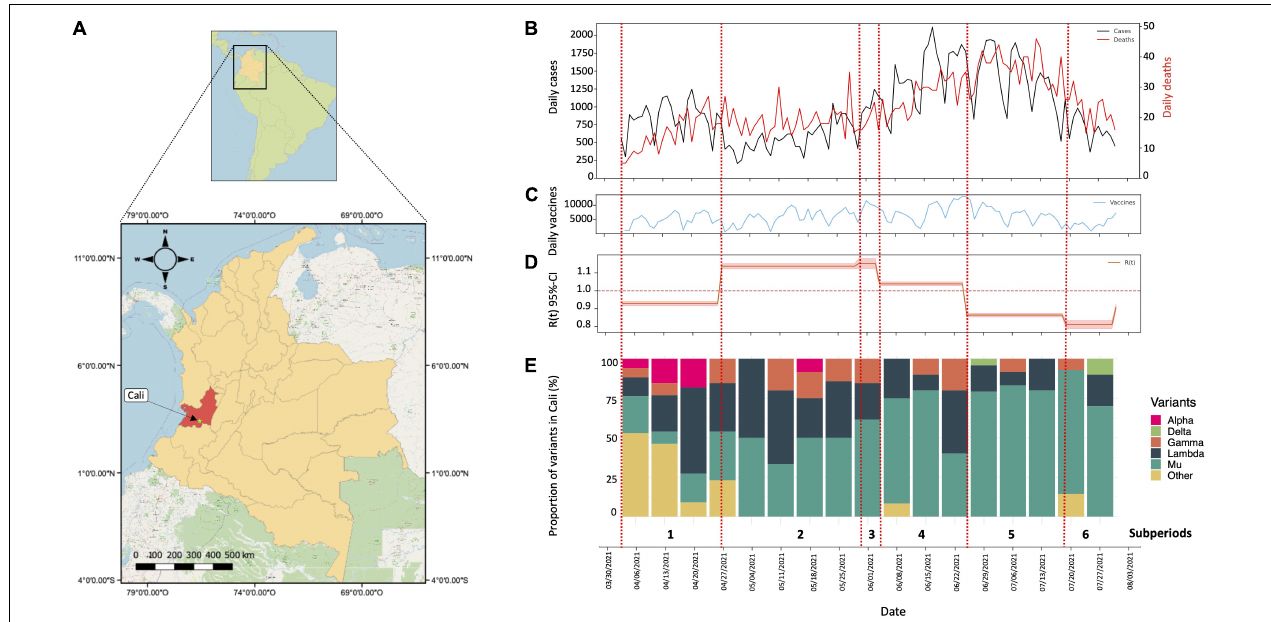
FIGURE 1 | Genomic surveillance and epidemic model of SARS-CoV-2 in Cali from 4 April 2021 to 31 July 2021. (A) Geographical location of the department of Valle del Cauca and its capital Cali. The map was constructed using the QGIS tools (QGIS Geographic Information System, Open-Source Geospatial) version 3.20.3-Odense. Foundation Project (http://qgis.osgeo.org). (B) Number of cases (black line) and deaths (red line) for SARS-CoV-2 reported daily in Cali from 4 April 2021 to 31 July 2021. (C) Number of vaccines applied per day in Cali from 4 April 2021 to 31 July 2021. (D) Value Rt calculated from 4 April 2021 to 31 July 2021. (E) Distribution of SARS-CoV-2 variants in Cali, Colombia. Proportion of VOC/VOI and other variants in Cali, Colombia from 4 April 2021 to 31 July 2021.